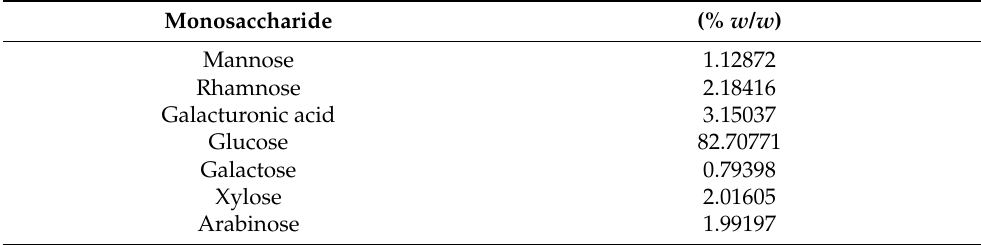
Table 1. The monosaccharide composition of